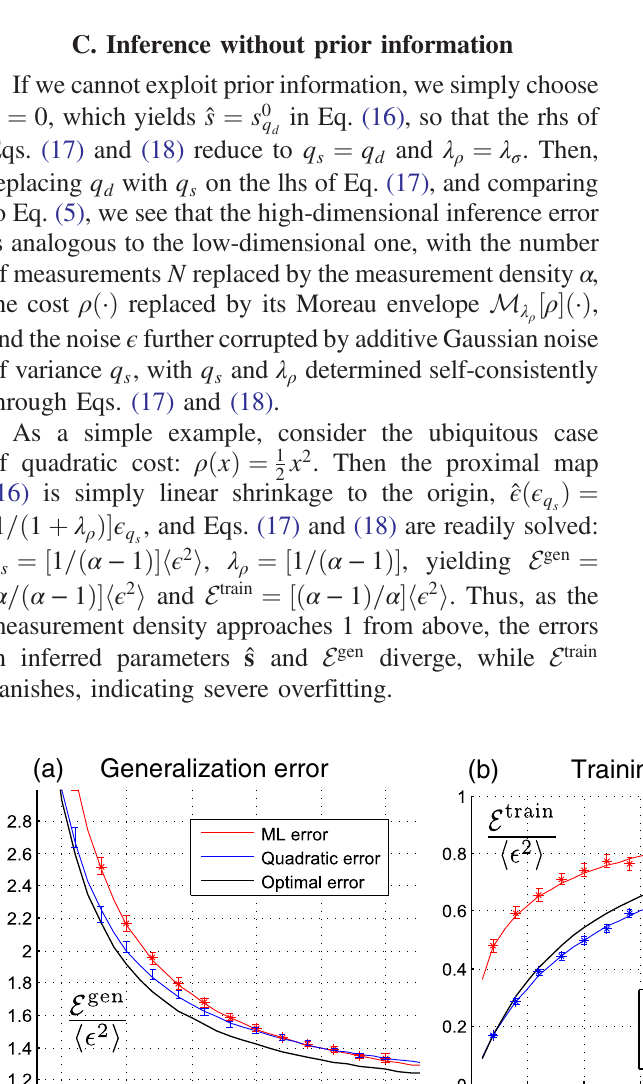
ffiffiffiffiffiffiffi p NP ¼ 250 ). The width of the